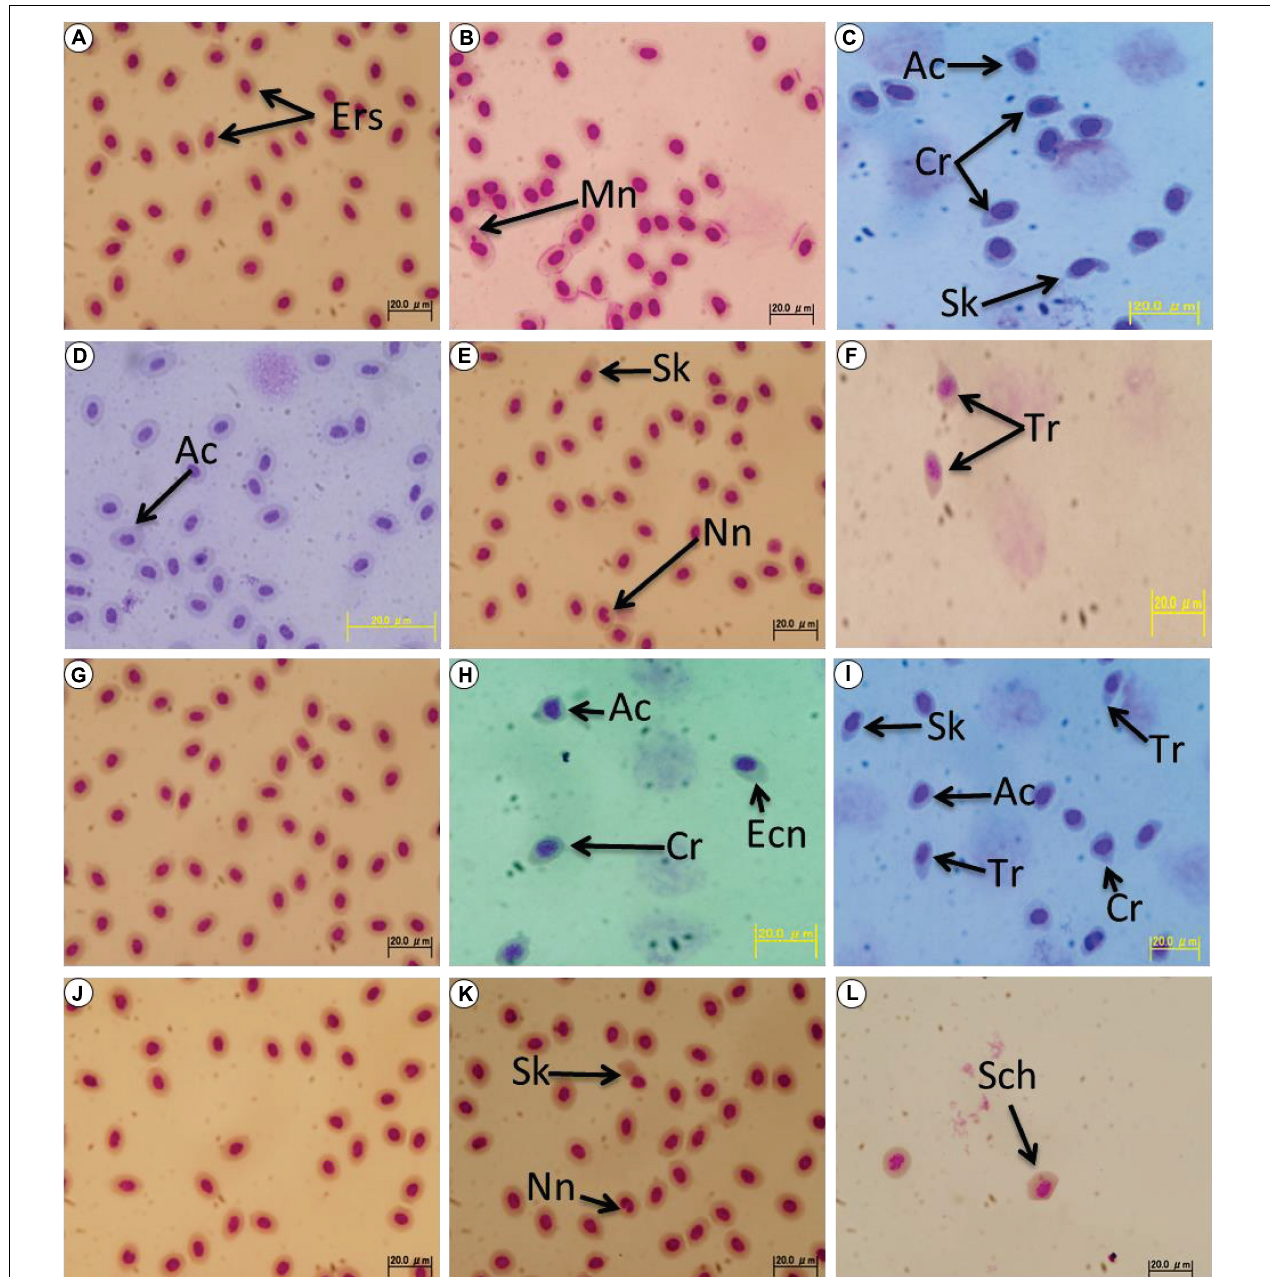
FIGURE 1 | Wright-Giemsa stained blood smears showing morphological and nuclear abnormal erythrocytes found in the irradiated medaka. (A,D) Normal erythrocytes collected from the non-irradiated wild-type female (Hd-rR strain) are presented. Morphologically altered erythrocytes or those with nuclear abnormalities were seldom observed in the non-irradiated wild-type fish, and an acanthocyte (Ac) is shown in d. (B,C) The erythrocytes of the wild-type fish 8 h after the end of the irradiation. (E,F) The erythrocytes of the wild-type fish 7 days after the end of the irradiation. (G,J) The erythrocytes of the non-irradiated p53-deficient fish. Abnormal erythrocytes were seldom observed. (H,I) The erythrocytes of the p53-deficient fish 8 h after the end of the irradiation. (K,L) The erythrocytes of the p53-deficient fish 7 days after the end of the irradiation. Ers, erythrocytes (normal erythrocytes); Tr, tear-drop cell; Cr, crenated cell; Ac, acanthocyte; Sk, sickled cell; Mn, micronucleated cell; Ecn, cell with eccentric nucleus; Nn, notched nucleus; and Sch, schistocyte.